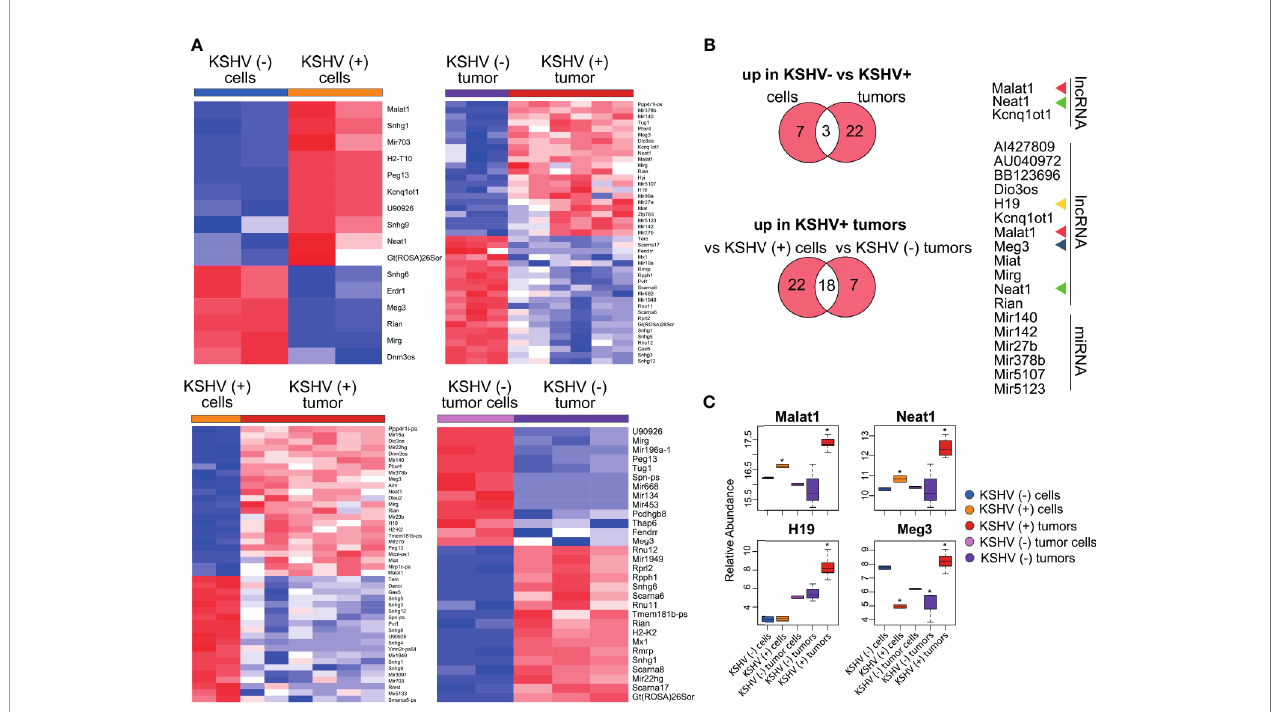
FIGURE 2 | Host lncRNAs expression. (A) Heat maps for fold change expression of host lncRNAs based on analysis of RNA sequencing data, all or the top 25 upregulated (red) and top 25 downregulated (blue) DE lncRNAs are shown in each comparison. (B) Venn diagrams showing upregulated host lncRNAs common in KSHV (+) cells and tumors versus KSHV ( − ) cells and tumors (top), and upregulated host lncRNAs common in KSHV (+) tumors versus KSHV (+) cells and KSHV (+) tumors versus KSHV ( − ) tumors (bottom). (C) Relative abundance of selected lncRNA RNAs across the different steps of the mouse-KS cell and tumor model. The asterisk refers to the level of statistical signi fi cance, established at p value